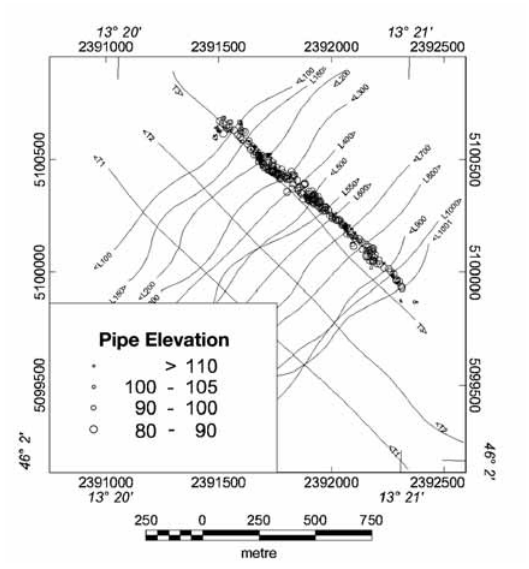
Fig. 4. Three dimensional Euler deconvolution map over the buried pipeline. Plan location of the pipe- line is well defined and most depth solutions plot in 80-90 m elevation interval, i.e. fairly consistent with real